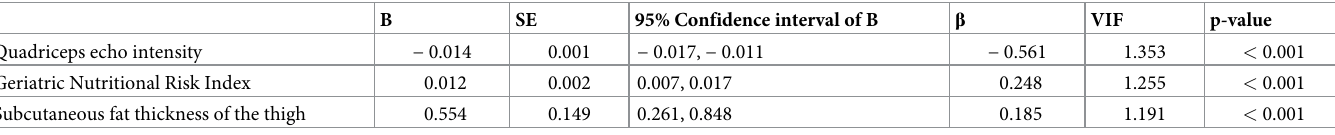
Table 4. Multiple regression analysis for muscle thickness in male model with stepwise method (n = 180).